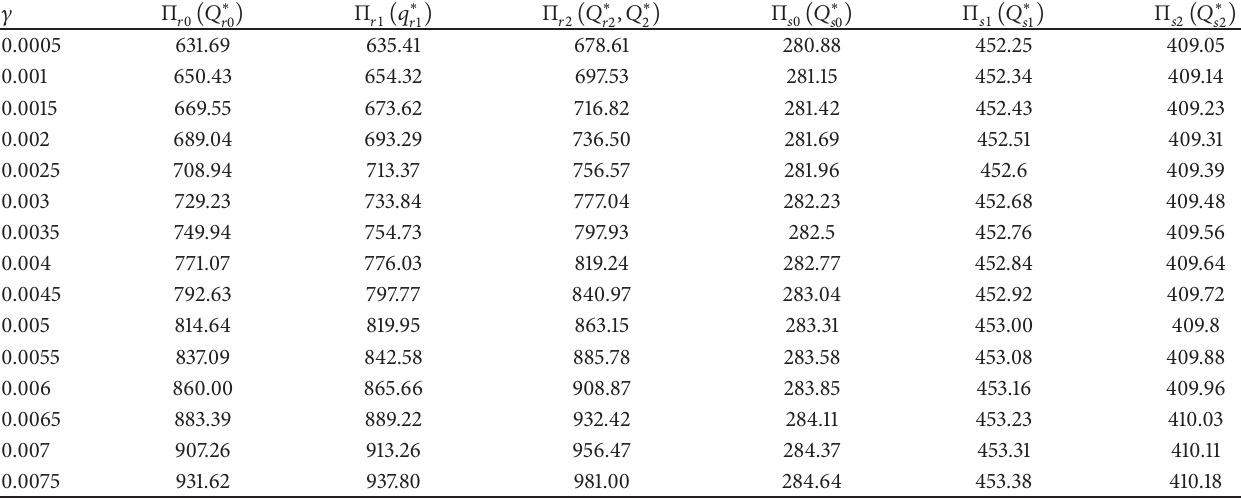
Table 5: The impact of 𝛾 on the optimal expected